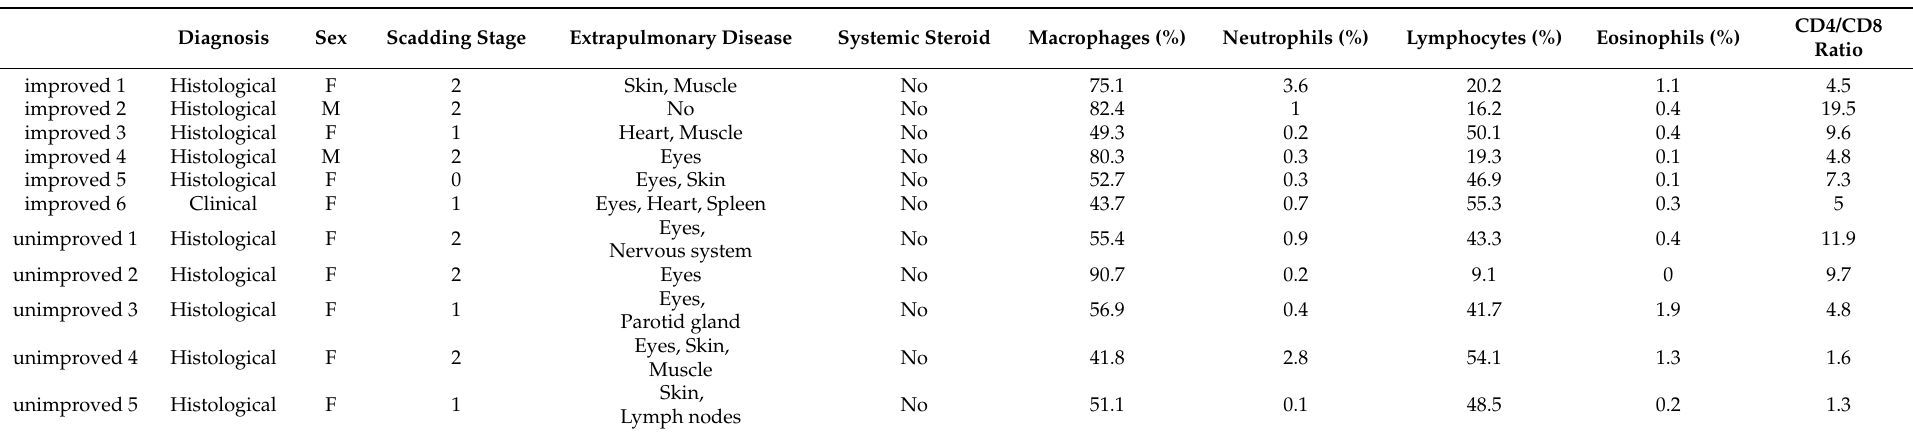
Table 1. Characteristics of patients and demographics of bronchoalveolar lavage